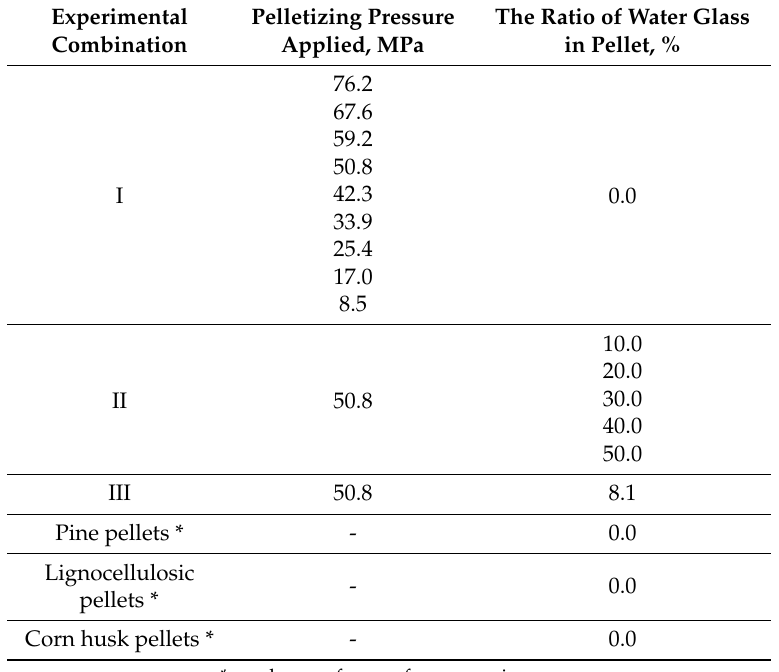
Table 3. Experimental matrix for carbonized refuse-derived fuel (CRDF) densification, n =